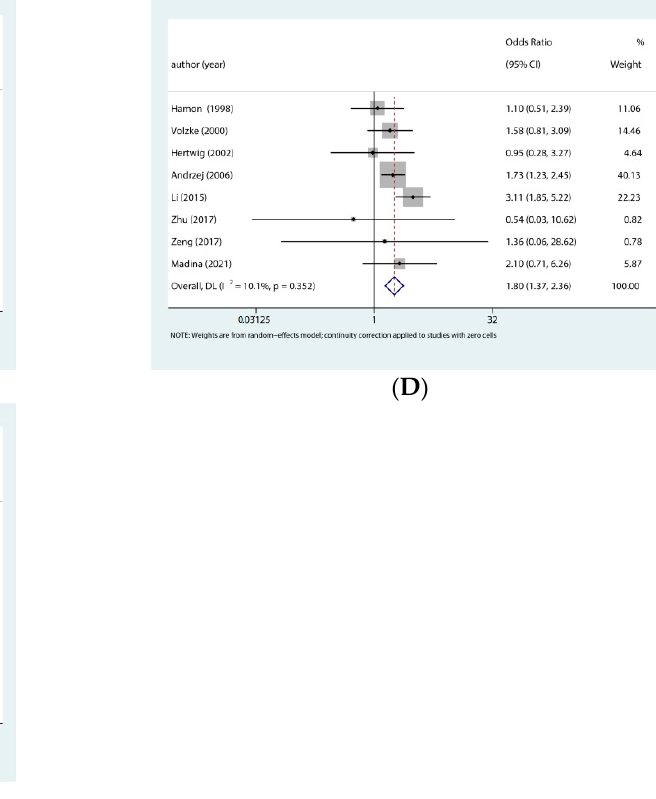
Figure 2. Forest plot from the meta-analysis on the association of the rs5186 polymorphism and risk of restenosis after PCI. ( A ) allele model: C vs. A; ( B ) homozygote model:CC vs. AA; ( C ) heterozygote model: AC vs. AA; ( D ) recessive model: CC vs. AC + AA; and ( E ) dominant model: CC + AC vs. AA. CI = confidence interval, OR = odds ratio [13–20].